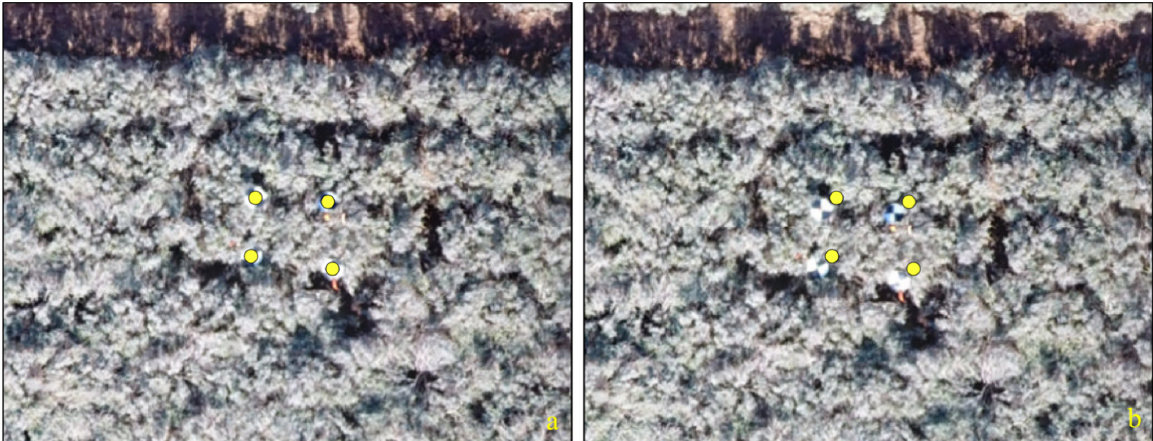
Figure 3. Radial error observed between a corrected, georeferenced orthomosaic ( a ) and an uncor- rected orthomosaic using UAS-derived referencing ( b ) from imagery dated 19 December 2019. Yellow dots represent the measured geographic locations of the measured markers.